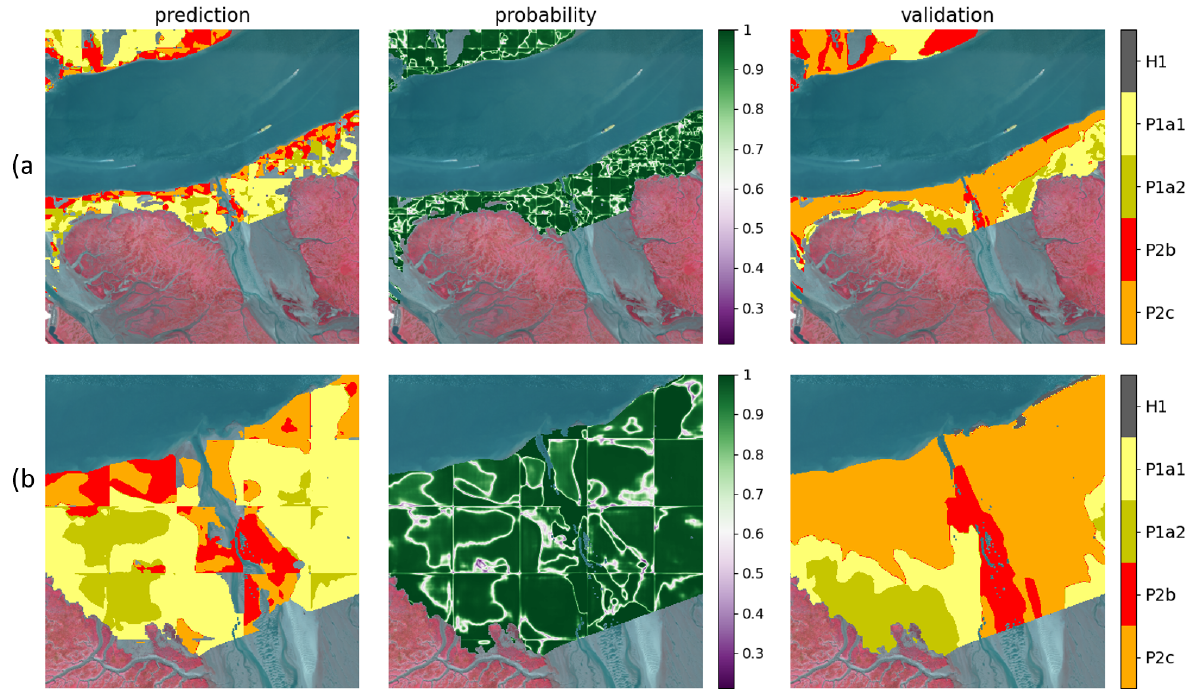
Figure 5. Map of the best U-net model. Figure (b) is a zoom-in of the figure (a). From left to right: predicted labels, predicted probabilities of the class with highest value, ground truth